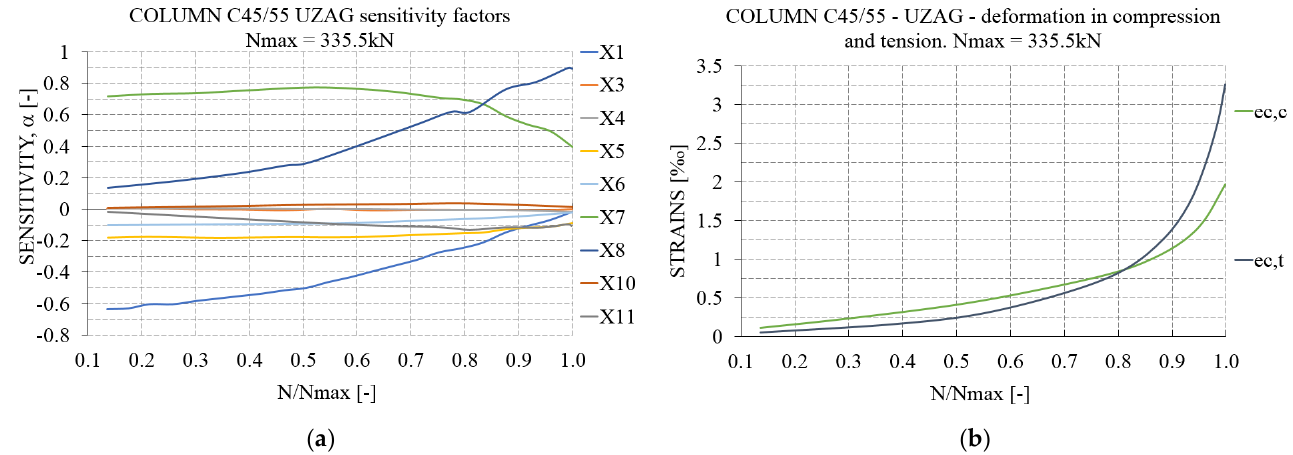
Figure 8. Sensitivity analyses at the cross-section level: ( a ) sensitivity of material parameters with respect to the applied normalized normal force (maximum bearing capacity of N = 335.5 kN); ( b ) strains in compression and tension with respect to the applied normal force, see also Table 3.